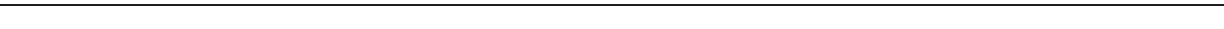
Fig. 7 Reduced metastasis and enhanced anti-tumor immunity by miRNA mimics. a qRT-PCR of miR-130a and − 145 in the plasma and Gr-1 + CD11b + cells (left), as well as T β RII in Gr-1 + CD11b + cells (right) from 4T1 tumor-bearing mice ( n = 6/each time point) at indicated times after systemic delivery of miRNA mimics through TVI. b qRT-PCR of miR-130a (left) or miR-145 (right) in Gr-1 + CD11b + myeloid cells, CD3 + lymphocytes, and CD19 + B cells sorted from peripheral blood of mice ( n = 3) 24 h after injection of miRNA mimics. c Metastasis nodule counts from mice that received miR control, miR-130a, and miR-145 mimics as a single agent or in combination with Paclitaxel (PAC) ( n = 13). d Flow cytometry of IFN γ + CD8 + cells from spleens of TCR-HA transgenic mice co-cultured (ex vivo) with Gr-1 + CD11b + cells from 4T1 tumor-bearing mice that were treated with miR-130a or miR-145 mimics. e Upper panels: miRNA in situ hybridization: miR-145 mimic distribution (green) in metastatic lungs of 4T1 tumor-bearing mice 12 h after miR mimic injection, with DAPI (blue), CD11b (red), and E-cadherin (Magenta). Scale bar: 20 μ m. Lower panel: the quantitative data of miRNA mean fl uorescent intensity in myeloid cells or tumor cells in metastatic lung of mice with miRNA mimic injections ( n = 23 – 30). f Flow cytometry of IFN γ + CD8 + T cells at metastasized lung from mice treated with miR-130a or miR-145 mimics ( n = 3). g CD8 T cell proliferation assay: fl ow cytometry of CSFE-labeled CD8 + T cells from splenocytes of TCR-HA transgenic mice co-cultured with sorted Gr-1 + CD11b + myeloid cells from the spleen of mice treated with miR-130a or miR-145 mimic injection (left), with quantitative data (right). h CTL assays: fl ow cytometry of 4T1.2 tumor cells (Sytox blue positive are dead) expressing HA co-cultured with splenocytes from TCR-HA transgenic mice and Gr-1 + CD11b + cells from the spleen of mice treated with miR-130a or miR-145, quantitative data (right). The percentage of targeted dead tumor cells = total dead cells minus dead cells from single culture of tumor cells, myeloid cells, and splenocytes. i Number of metastasis in 4T1 tumor-bearing mice treated with miR mimics with CD4 or CD8 α neutralizing antibody or IgG control. The data are presented as mean ± SEM, and Student ’ s t test was performed. * p < 0.05, ** p < 0.01, *** p <